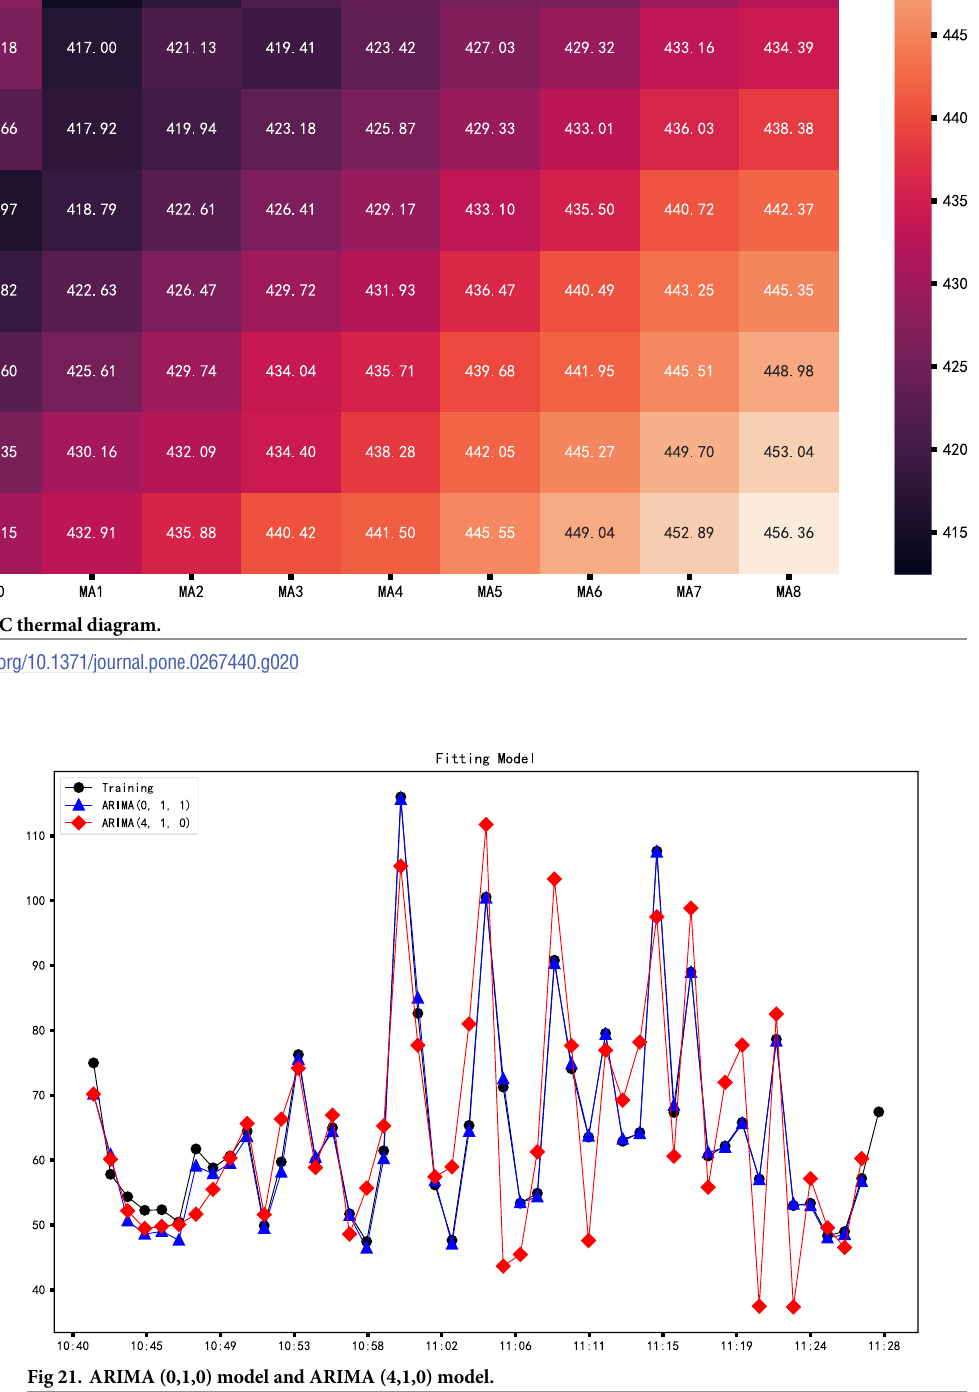
PLOS ONE | https://doi.org/10.1371/journal.pone.0267440 May 5,